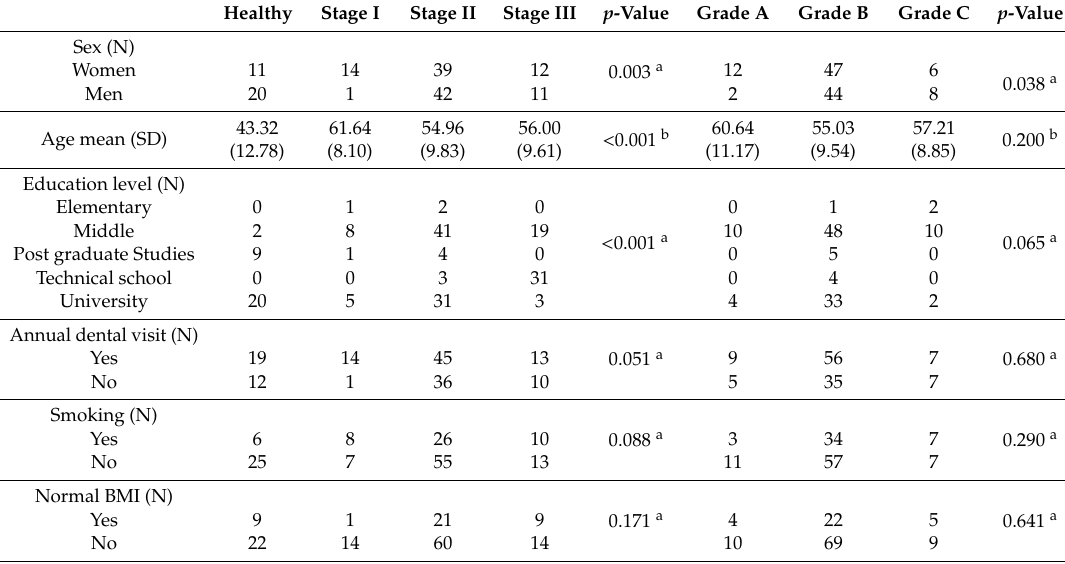
Table 1. Patient characteristics (N = 150 Greek